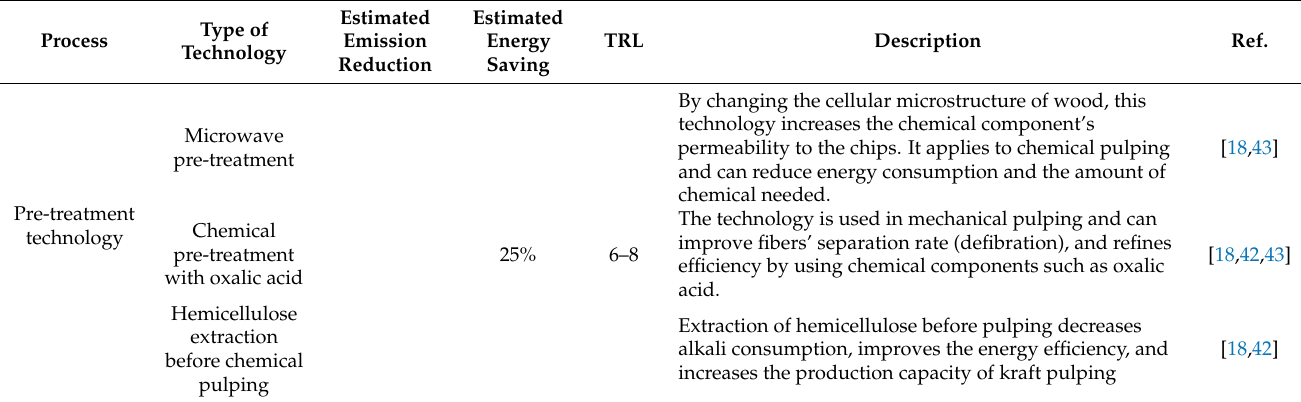
Table 9. An overview of the innovative technologies (IT) for the pulp and paper sector based on the literature